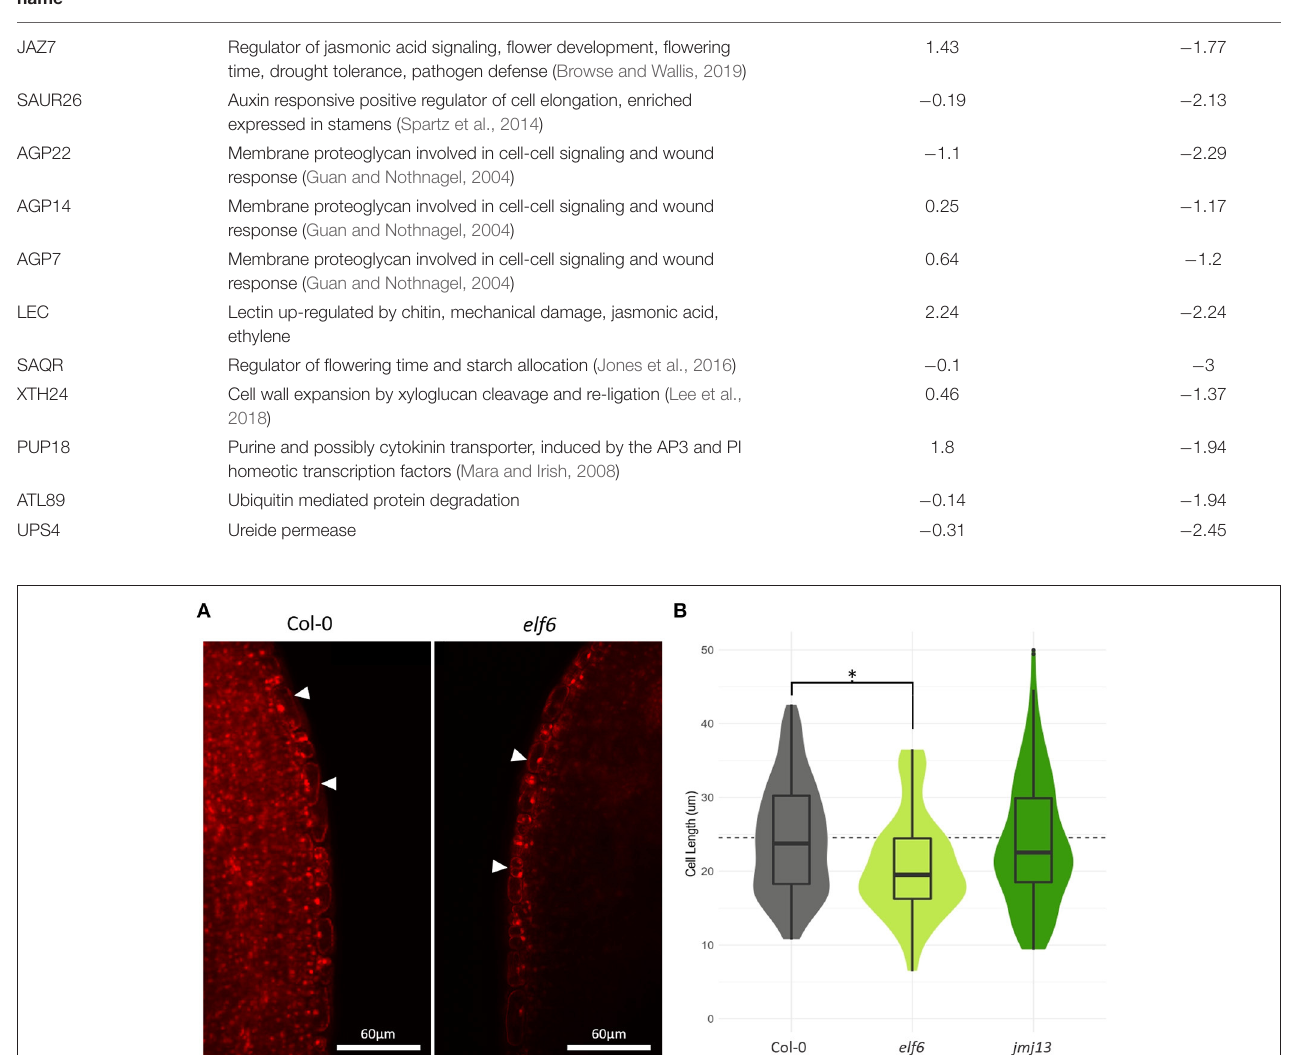
TABLE 2 | Predicted JMJ13 phenotypic target genes as determined by screening of transcriptome and epigenome data. JMJ13 target gene